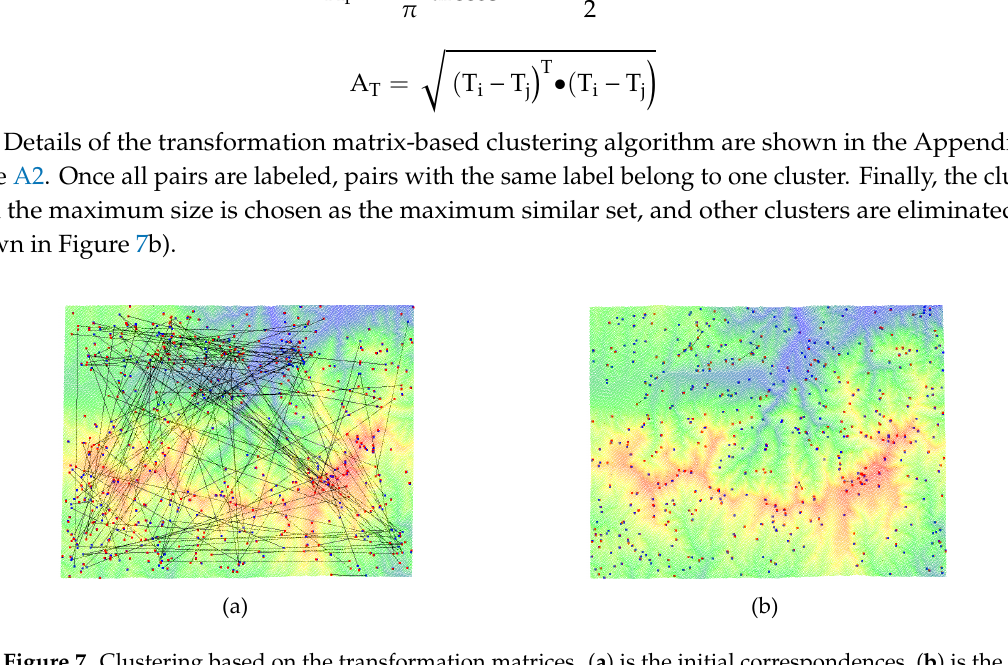
Figure 7. Clustering based on the transformation matrices. ( a ) is the initial correspondences, ( b ) is the maximum similarity set.